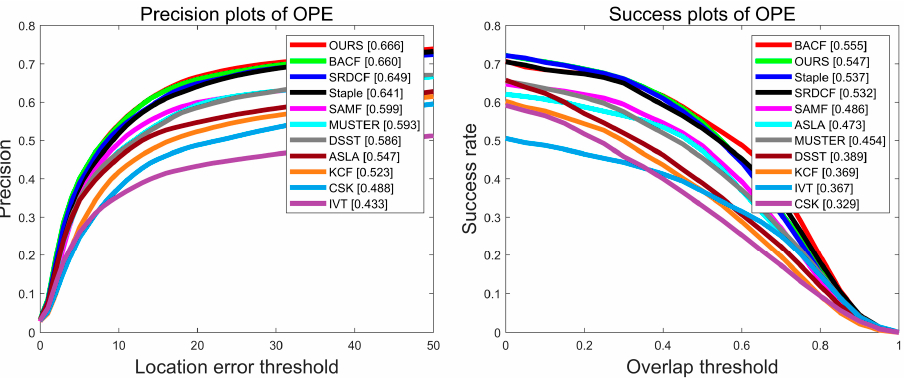
Figure 14. Precision plot and success plot of different algorithms on the UAV123 dataset.